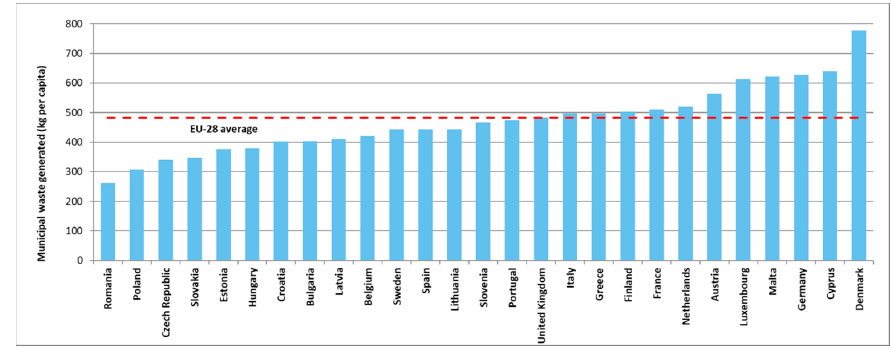
Figure 2. Municipal waste generated by country in 2016. The data source from [7].